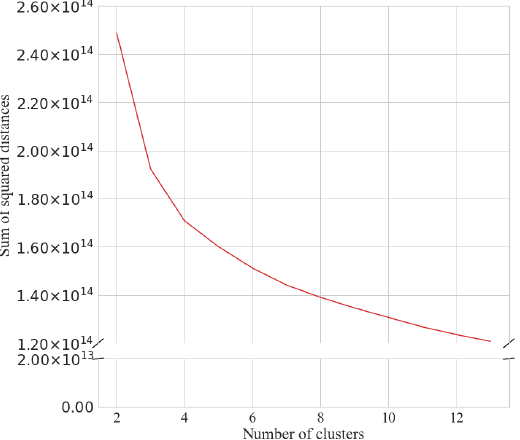
Figure 3. Elbow plot for determining the number of weekly step behaviour